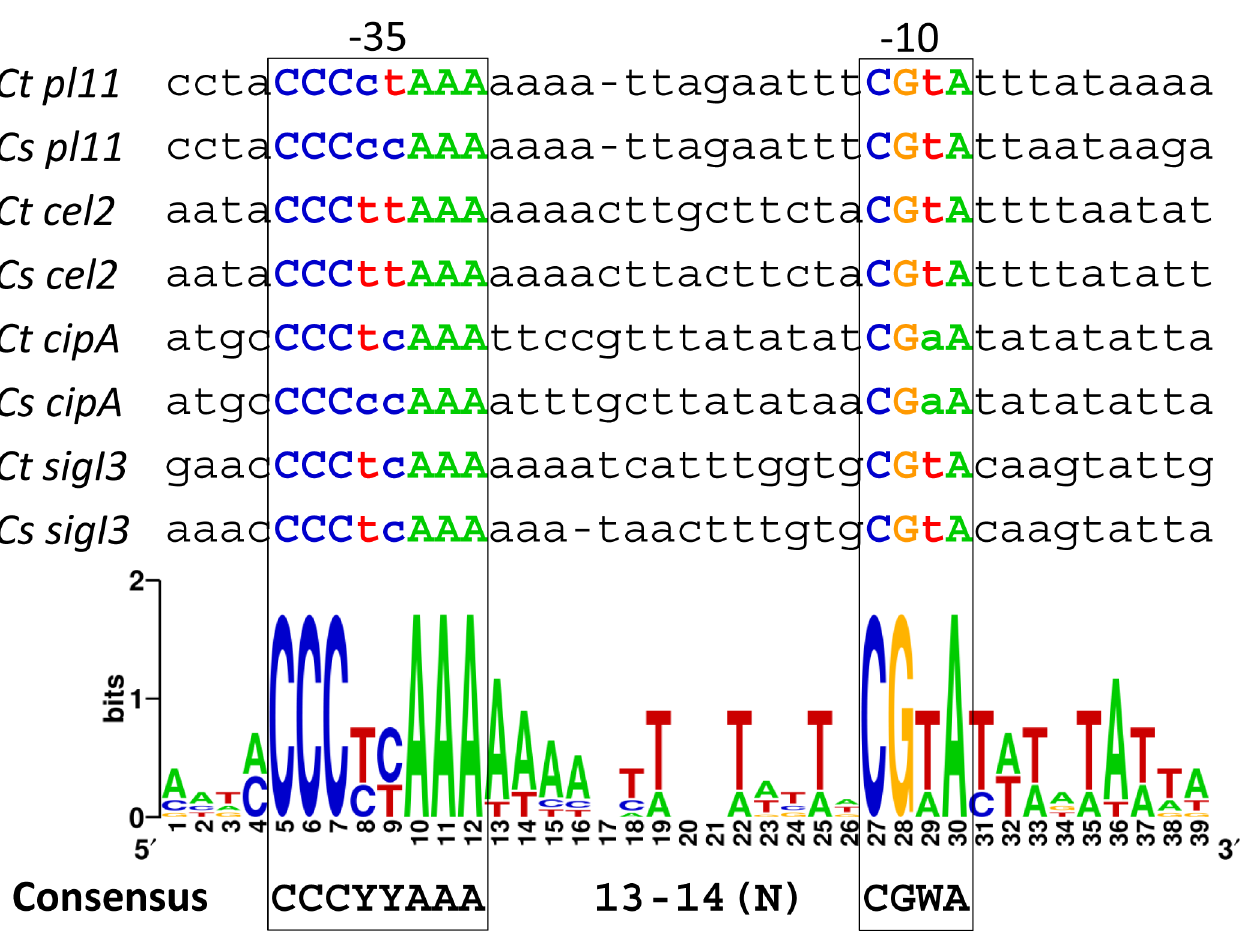
Fig 4. Identification of conserved elements of σ I3 -dependent promoter sequences. WebLogo generated with σ I3 -dependent promoter sequences of C . thermocellum and orthologous promoter sequences of C . straminisolvens .